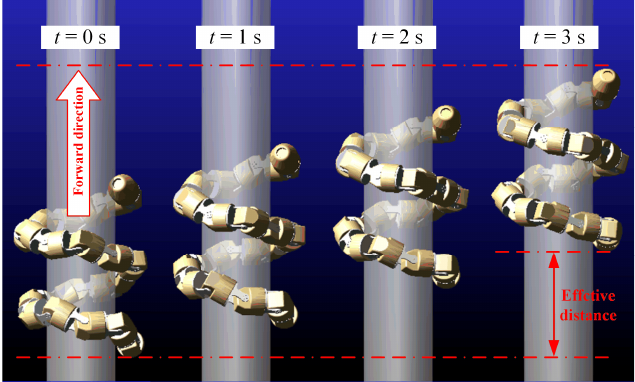
Figure 13. The Spiral climbing motion of the snake-like robot.